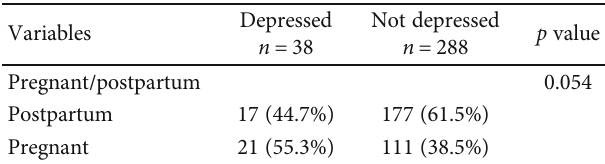
Table 3: Comparison of the prevalence of depression between pregnant and postpartum adolescents ( n = 326